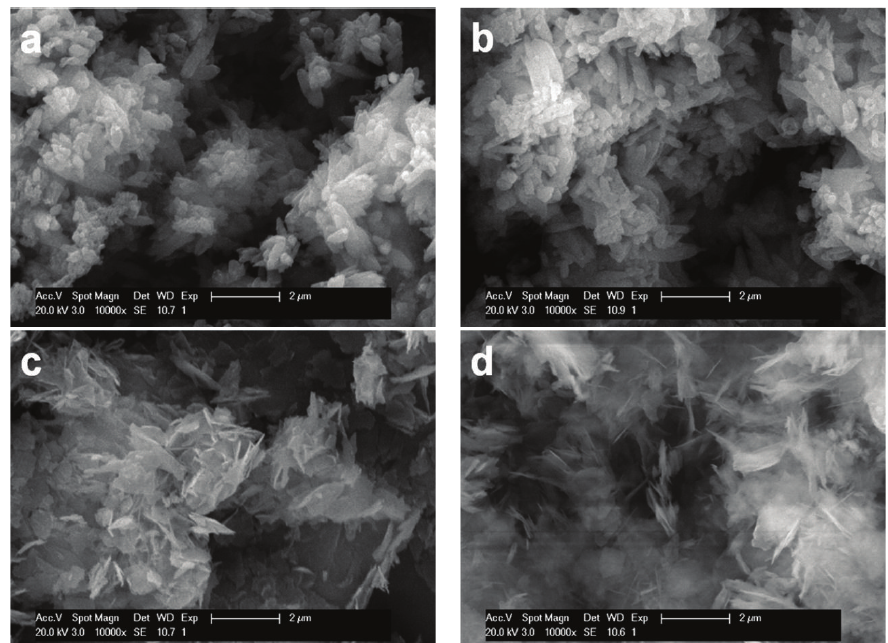
Figure 6: Morphology of CaO, carbonated for one hour, at 50 ∘ C and 50 g/L, with mechanical stirring, without NiNP addition (a) and with NiNP addition (b); morphology of MgO, carbonated with the same parameters except solids loading of 35.95 g/L, without NiNP addition (c) and with NiNP addition (d), realized by SEM imaging.